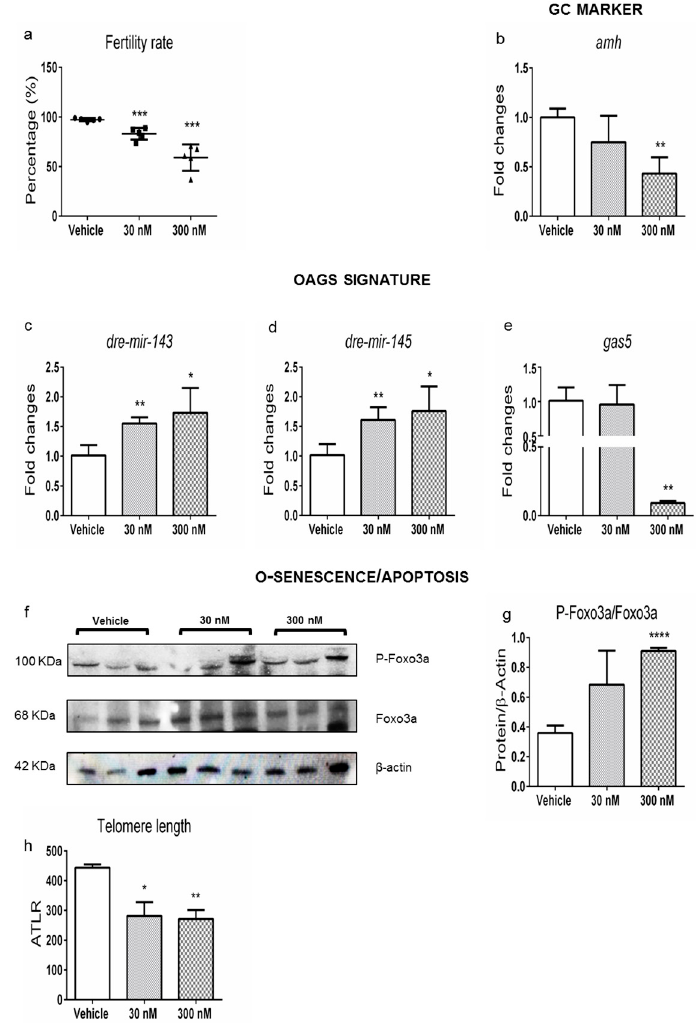
Figure 2. Developmental and lifelong exposure to CPF in zebrafish ovaries promotes POA. ( a ) Graph represents the fertilization percentage estimated by counting the number of fertilized eggs obtained from five independent matings involving zebrafish females exposed to CPF vs. females not exposed (Vehicle). ( b ) Granulosa cell markers ( amh ) were detected by RT-qPCR. ( c – e ) OAGS genes ( dre-mir-143 , dre-mir-145, and gas5 ) were verified by RT-qPCR. ( f , g ) Representative Western blot analysis showing the level of Foxo3a/P-Foxo3a protein following CPF treatment ( n = 3/group). ( h ) Telomere length was measured from total genomic ovaries DNA by using a qPCR. Data were obtained normalizing using tubaI for mRNA, β -actin for proteins, and U6 for miRNA). Data are mean ± s.d. with five animals per group. Significant differences are indicated with * p < 0.05; ** p < 0.01, *** p < 0.001, and **** p < 0.0001 using Student’s t